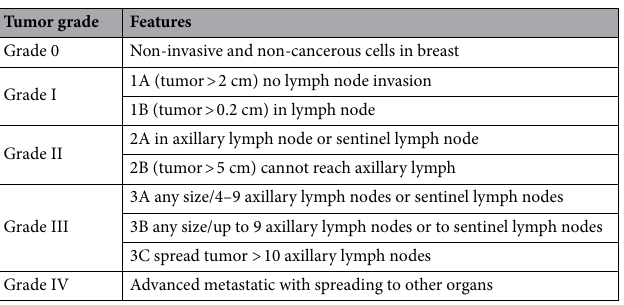
Table 3. Features of breast cancer tissue